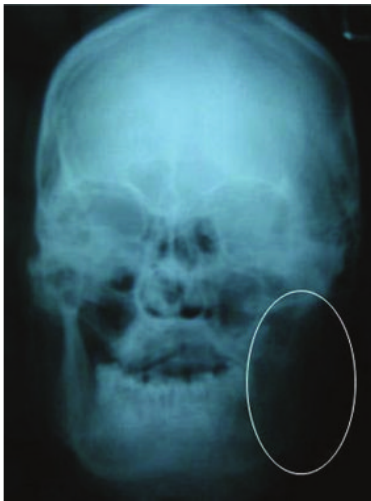
Figure 2: Posteroanterior view of skull revealing osteolysis involv- ing left body and ramus of the mandible till the condylar head.